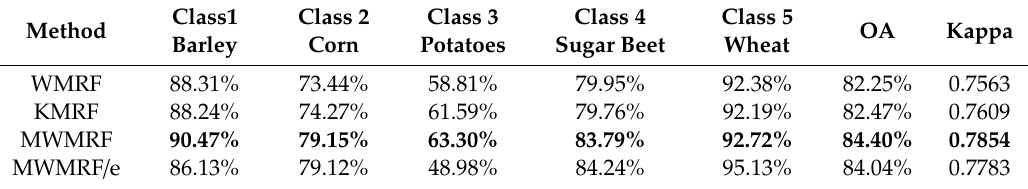
Table 2. Comparison of the pixel-based classification algorithms for the Wallerfing dataset.